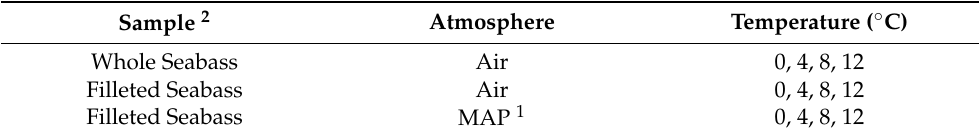
Table 1. Sea bass handling and storage